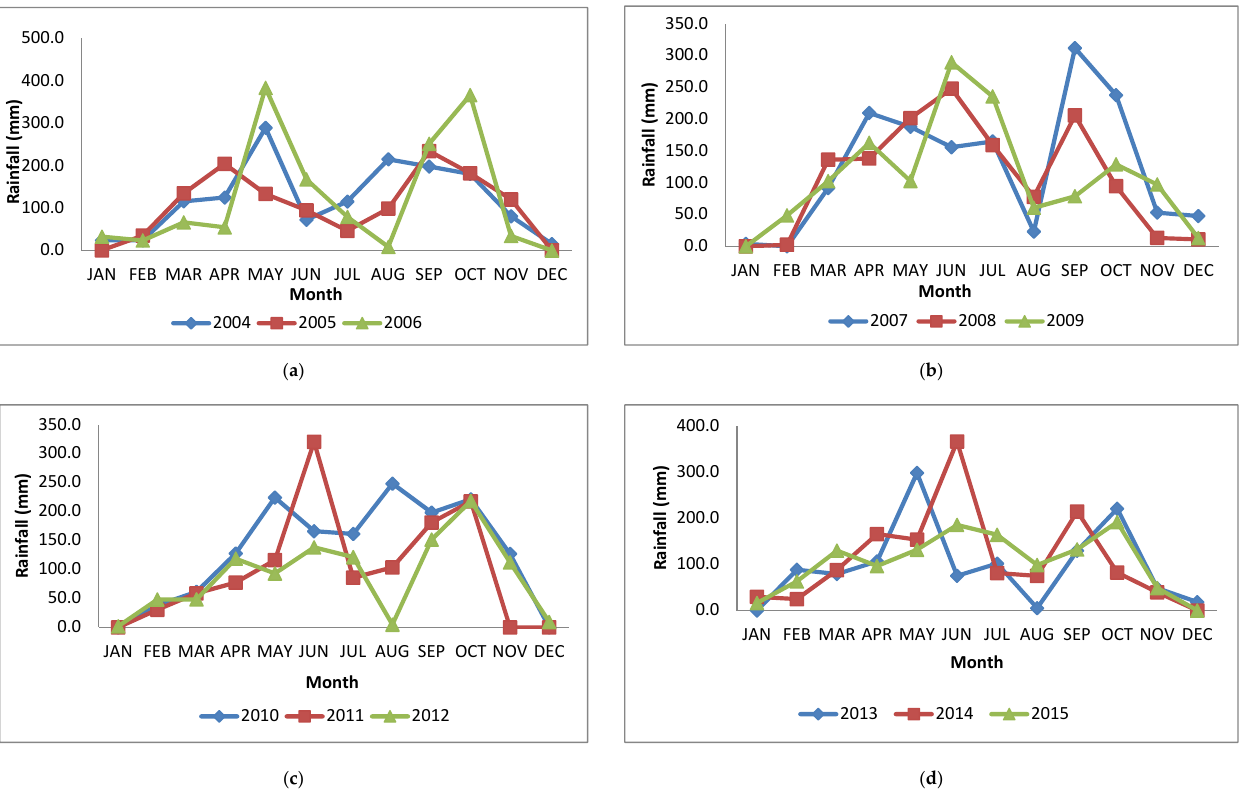
Figure 6. ( a – d ): Intra-annual rainfall distribution in Ejura-Sekyedumase Municipality (2004–2015) .